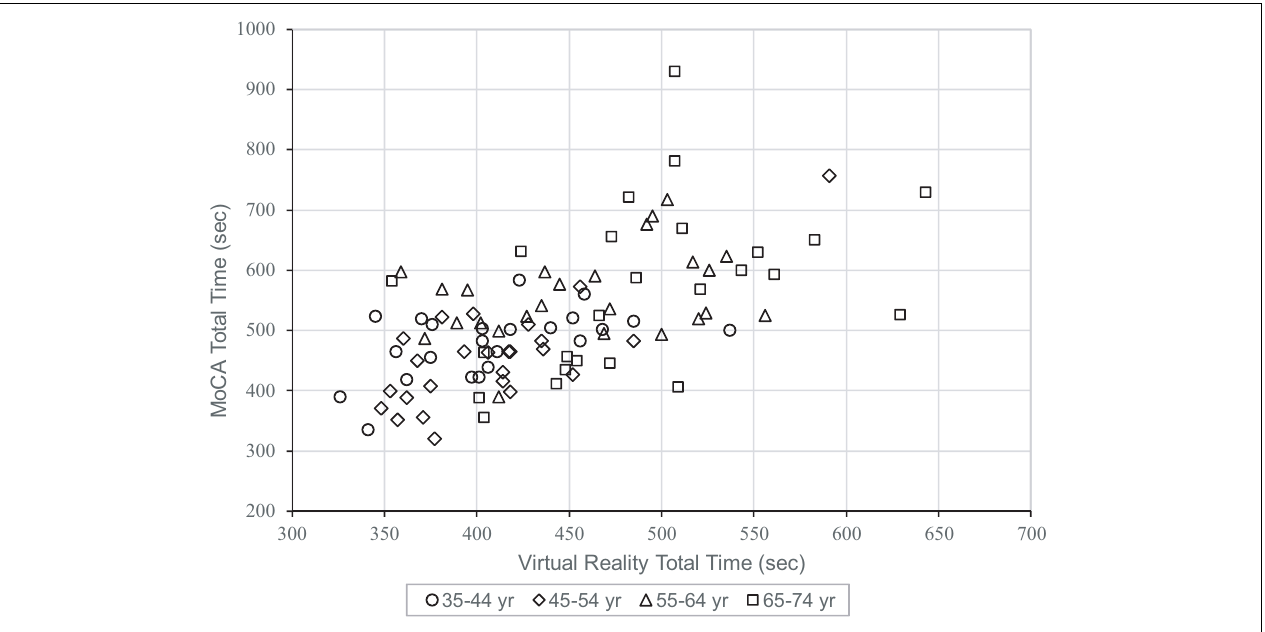
FIGURE 2 | Scatter plot of Montreal Cognitive Assessment (MoCA) vs. Virtual Reality (CAVIRE) total time taken.